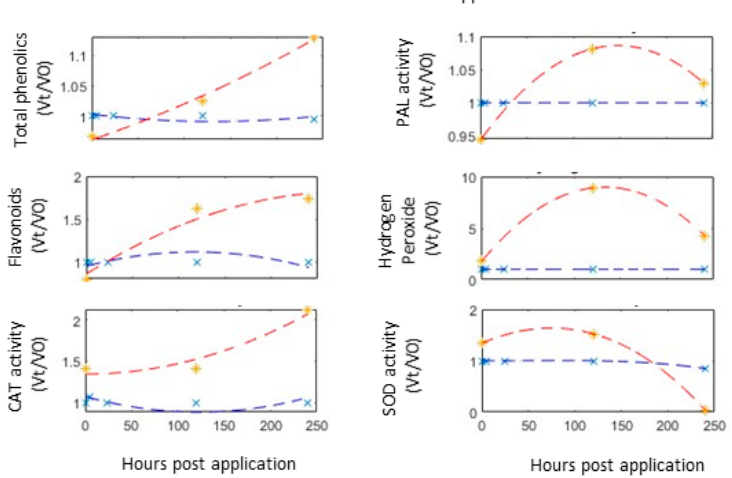
Figure 3. Mathematical Modeling of plant immune responses to self eDNA late application. Data showed in normalized dimensionless values for each sampling time in hours post-treatment application. Blue lines represent responses to first application and red lines represent responses to second application of treatment.